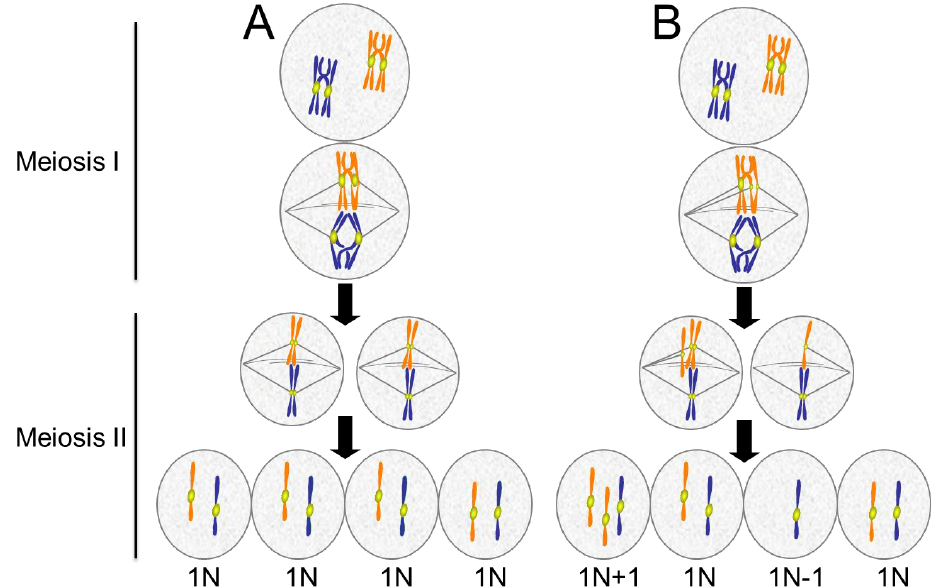
Figure 6. Meiotic errors lead to aneuploid gametes. ( A ) Normal meiosis consists of two chromosome segregation events without an intervening S phase. In Meiosis I, homologous chromosomes pair and undergo recombination, forming crossovers. In anaphase of Meiosis I, the homologous chromosomes segregate. In Meiosis II sister chromatids separate. The final product is four haploid (1N) cells. ( B ) Defects in meiosis result in aneuploidy. In the example shown, the chromatids of one chromosome separate prematurely and segregate to opposite poles resulting in an imbalance of chromatids in the two cells produced by Meiosis I. When these cells undergo Meiosis II, each produces one normal haploid (1N) gamete and one aneuploid (1N + 1 or 1N − 1) gamete. For simplicity, only two chromosome pairs are depicted.